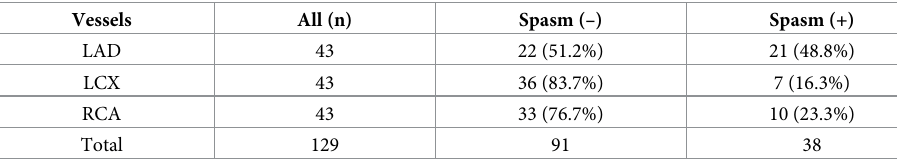
Table 2. Per vessel analysis for coronary spasm on